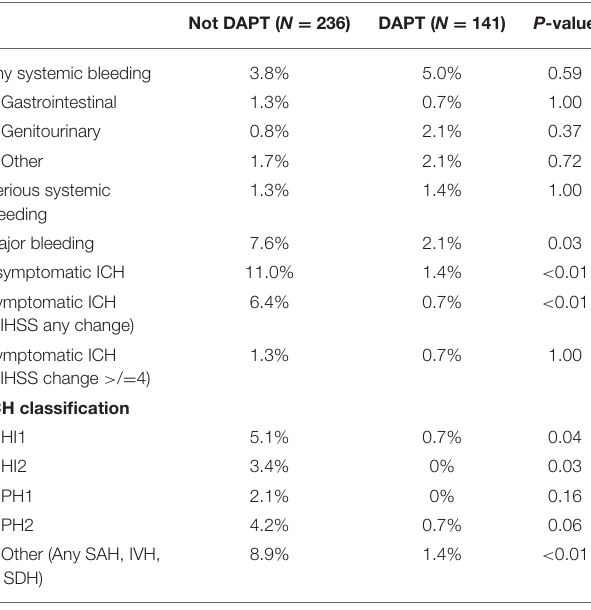
TABLE 2 | Bleeding rates by antiplatelet therapy at the time of